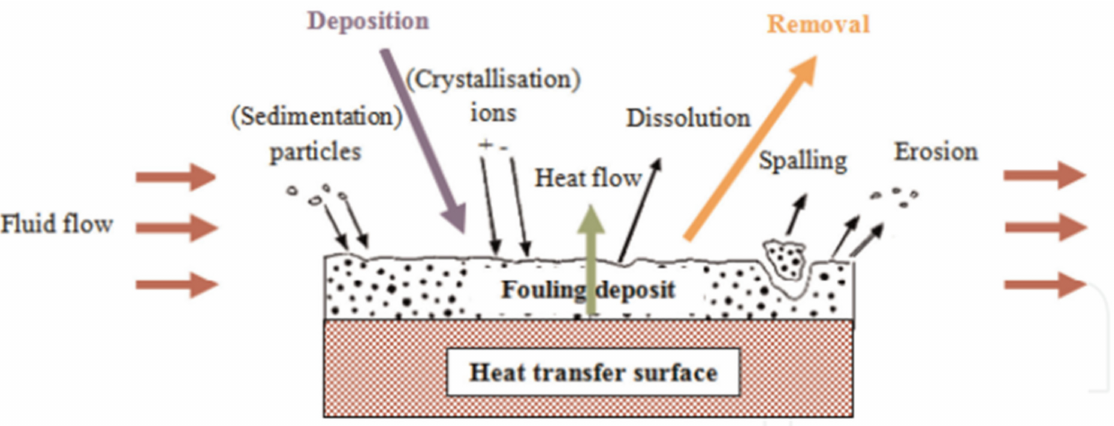
Figure 2. Overall fouling process